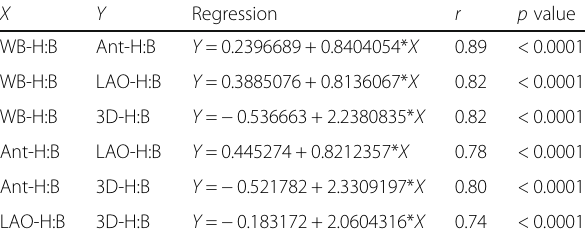
Table 3 Regression analysis and Pearson ’ s correlation between each individual method for heart-to-background (H:B) uptake